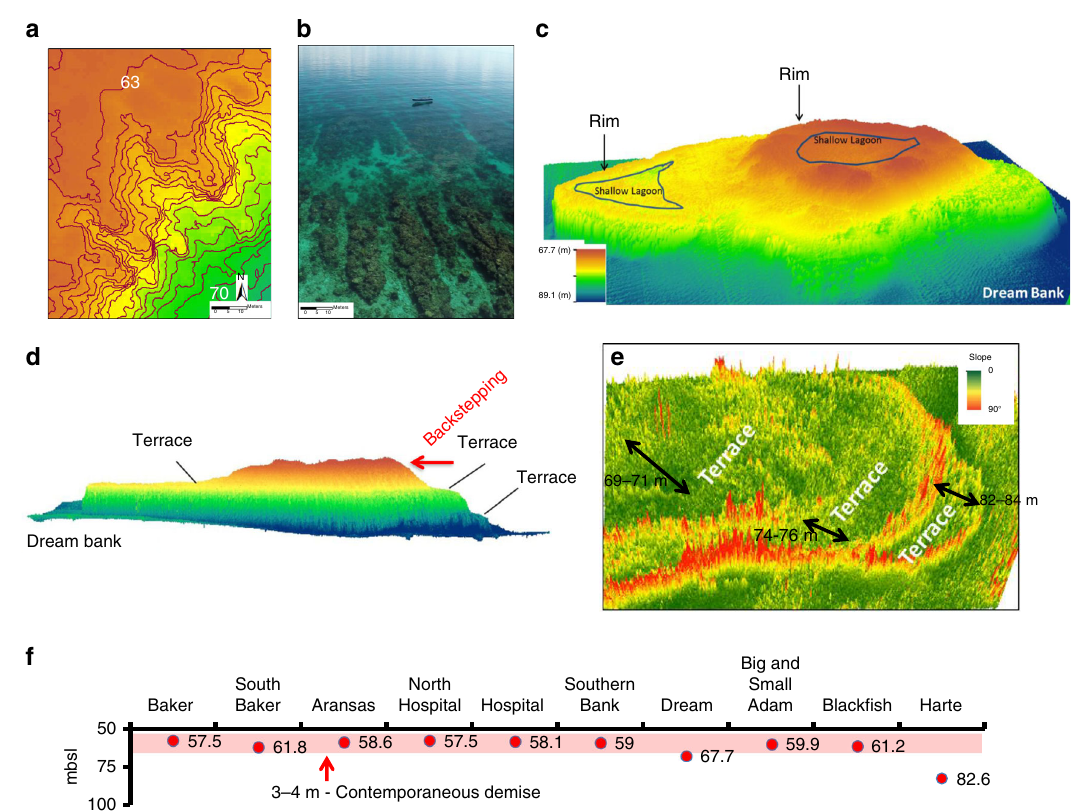
Fig. 3 True coralgal reef morphologies as evidenced by high-resolution multibeam bathymetric maps. a Detailed bathymetry (contour interval 0.5 m) displays a clear example of spurs and grooves on the south-eastern margin of Baker Bank (see Fig. 2a for location), b Picture of modern spurs and grooves in front of the Belize Barrier Reef east of Tobacco Range, (Photo by Brandon Martin) as an analog for Fig. 3a; note the similar scales between both fossil and modern spur and grove sets. c Oblique bird eye view of Dream Bank displays clear atoll morphologies, rimmed margins enclosing shallow lagoon, at two different levels. d Side view of Dream Bank (VE: ×20) displays a series of terraces, characteristic morphology of coralgal reef backstepping in response to punctuated high rates of sea-level rise 26 . e Slope angle map for Dream Bank clearly identi fi es the well-de fi ned terraces and faces (shown in 3D), where red color (steep slopes) represents terrace faces and green color (gentle slopes) terrace fl ats. f Plotted depths to crest of the ten drowned banks, eight of which lie within a 3 – 4 m-depth range from 57.5 to 61.8 mbsl. Such a narrow depth range testi fi es to their contemporaneous